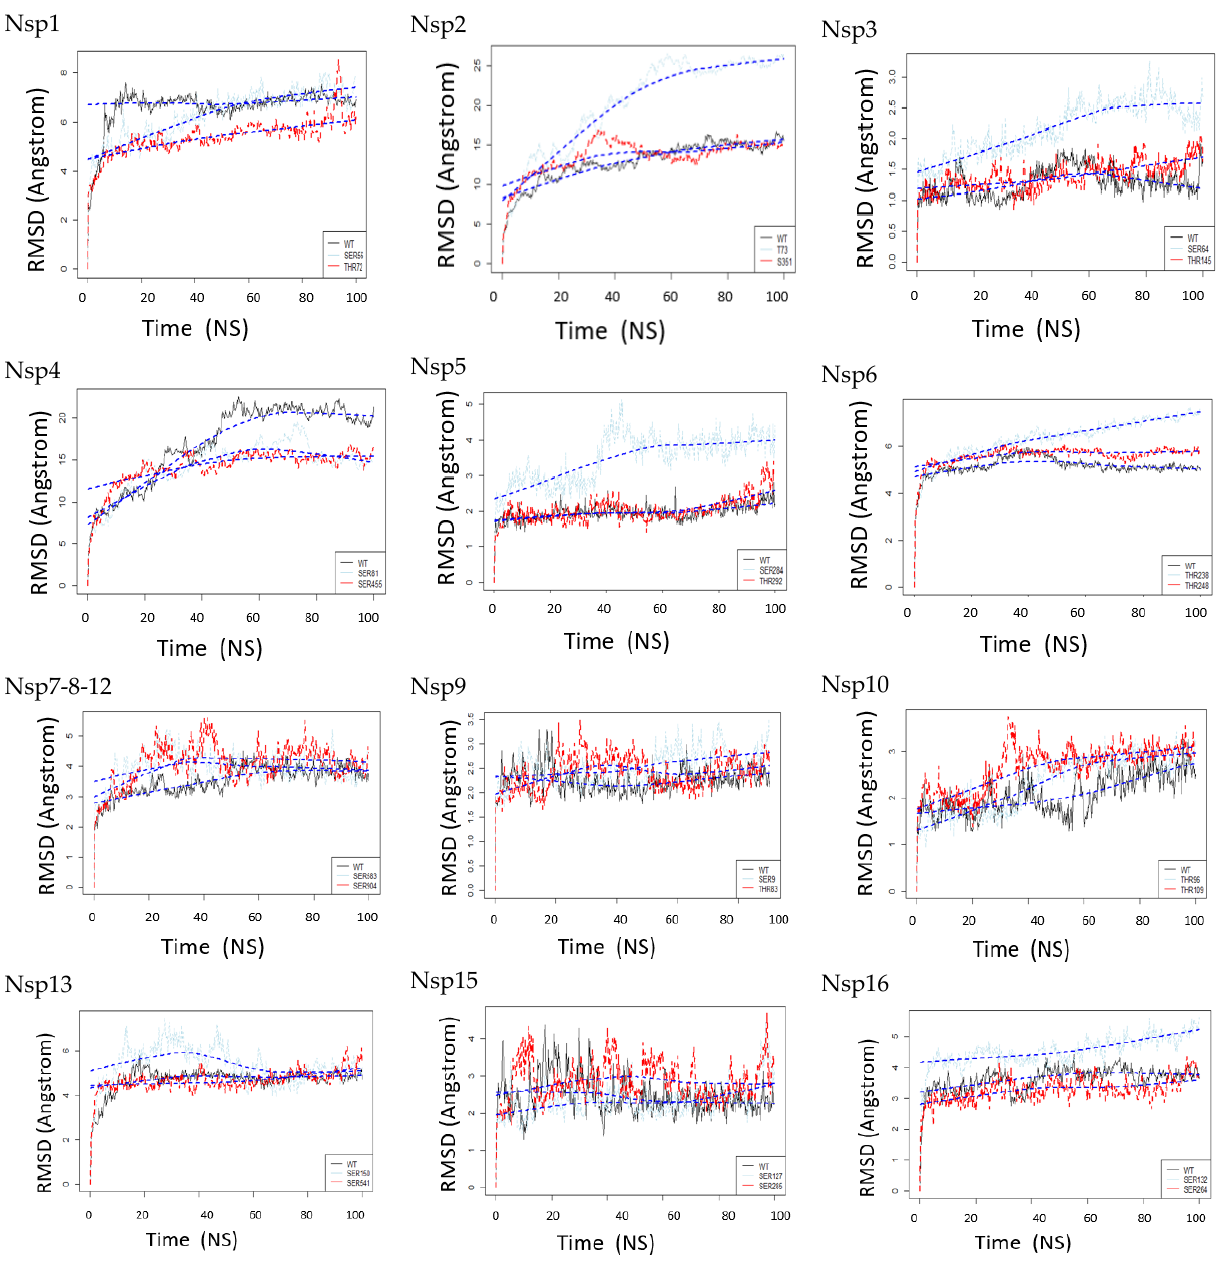
Figure 3. The RMSD of all residues for the 36 MD simulated structures (12 un-phosphorylated (Black), 12 phosphorylated sites 1 (Light blue), and 12 phosphorylated sites 2 (Red)) throughout the simulation (100 ns) compared to the starting confirmation (un-phosphorylated WT at time 0 ns) to measure the behavior effect of phosphorylation of 12 phosphorylated sites 1 and 12 phosphorylated sites 2 on the nsps. Table 3. RMSD differences between wild type and phosphorylated structures.